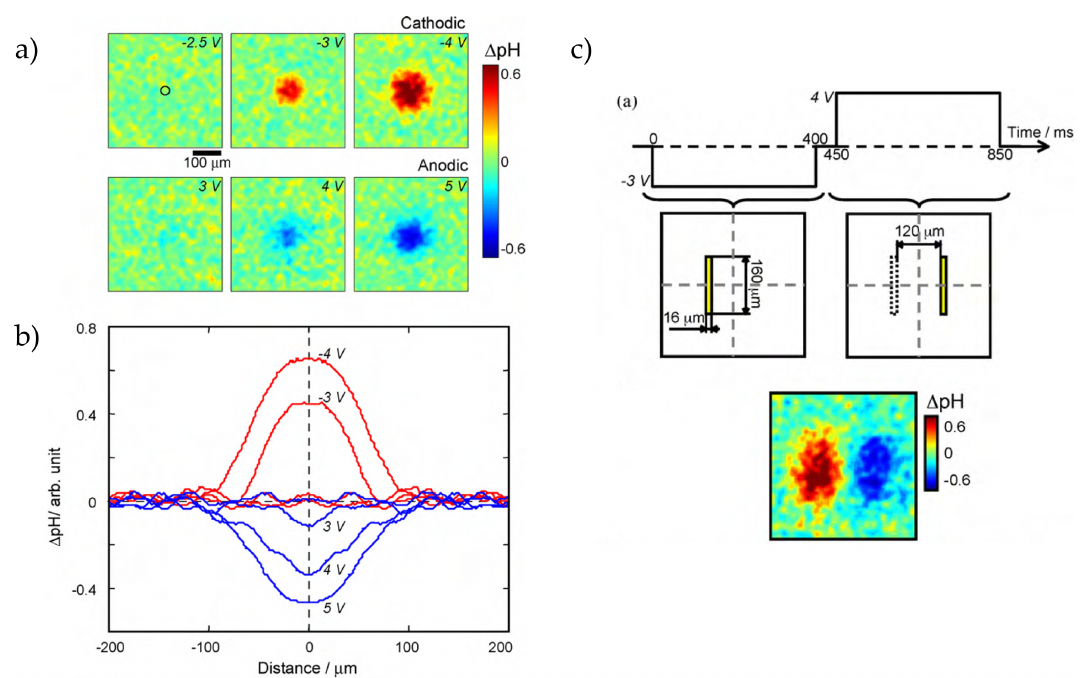
Figure 6. ( a ) Fluorescence pH images for a-Si:H with a tin antimonate (ZnO/Sb 2 O 5 )-dispersed epoxy passivation layer for different applied potentials with a constant rear-side illumination: For negative applied potentials, the pH changes to more alkaline value, while for positive applied potentials, the electrolyte becomes more acidic at the illuminated areas. ( b ) pH gradients for different potentials: With higher positive or negative potentials, the gradient gets wider with an absolute higher pH change. ( c ) Customized pH gradient by first applying a cathodic potential and illuminating the first area for 400ms, where the pH gets more alkaline, followed by switching to anodic potentials for additional 400ms together with the illumination of the seconds area. Reprinted from Reference [57] Copyright (2020), with permission from